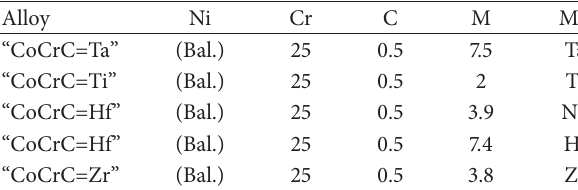
Table 2: Chemical compositions of the studied